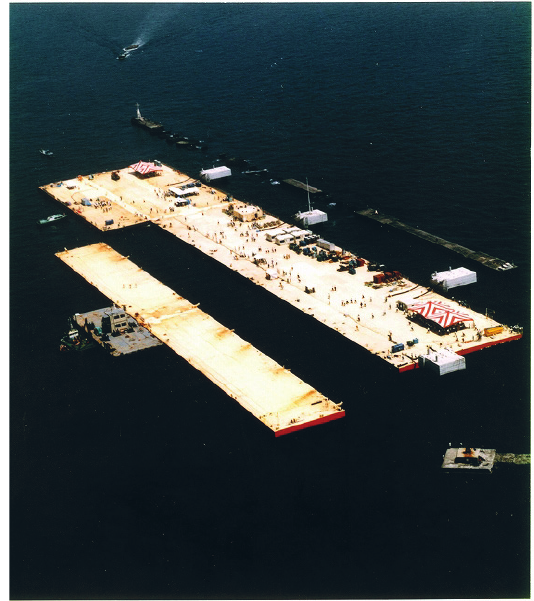
Figure 16. Picture of “Mega-Float Project” (courtesy of the Marine Technology and Development Dept. at the Shipbuilding Research Center of